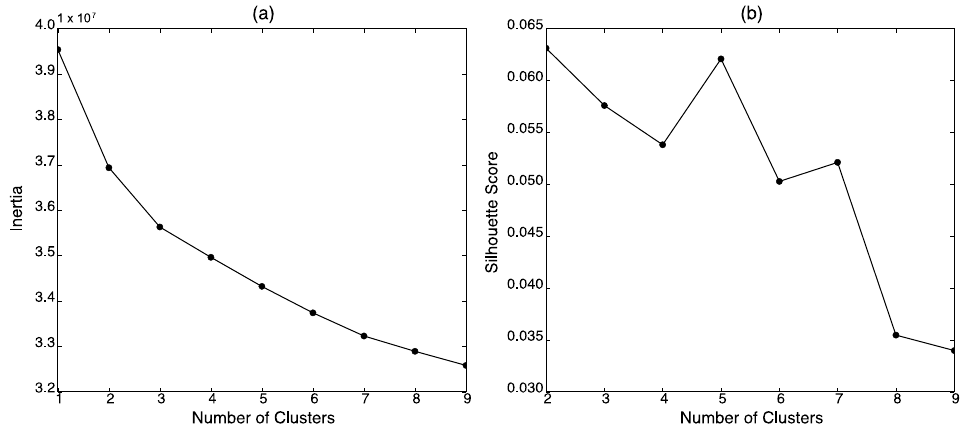
Figure 1. Determining the optimal number of clusters via k-means clustering using ( a ) the elbow method and ( b ) the silhouette score method.